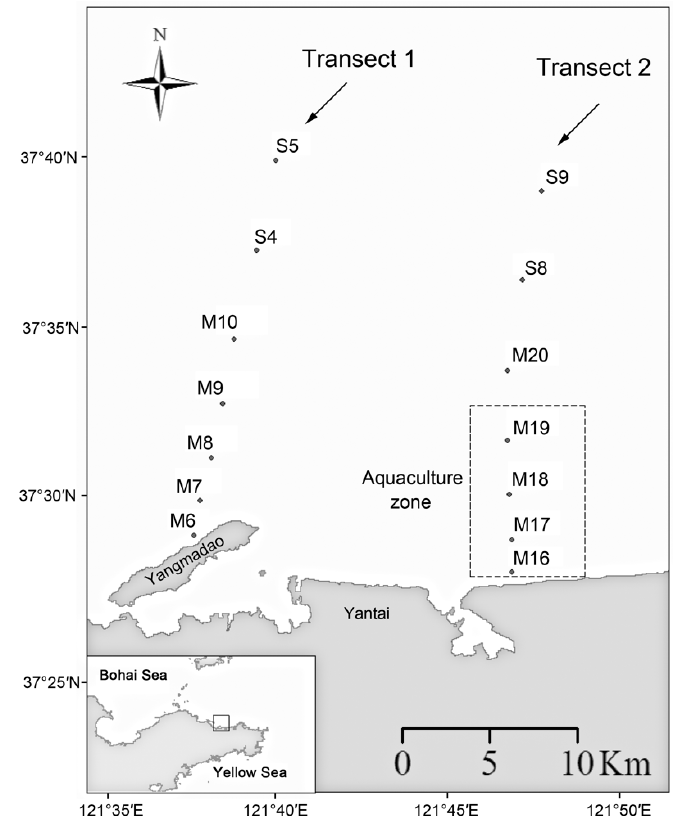
Figure 1. Maps of the study region in a seasonal hypoxia coastal zone showing the locations of the sampling stations along the two transects. The aquaculture zone was showed in the square with